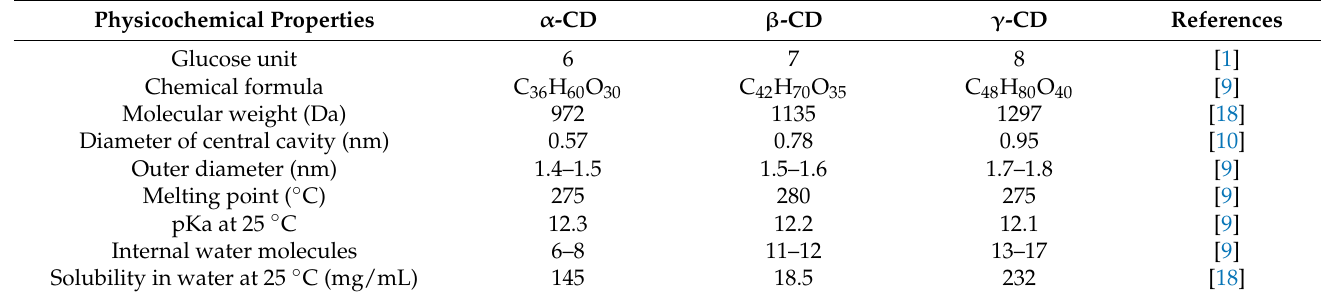
Table 1. Physicochemical properties of the three natural